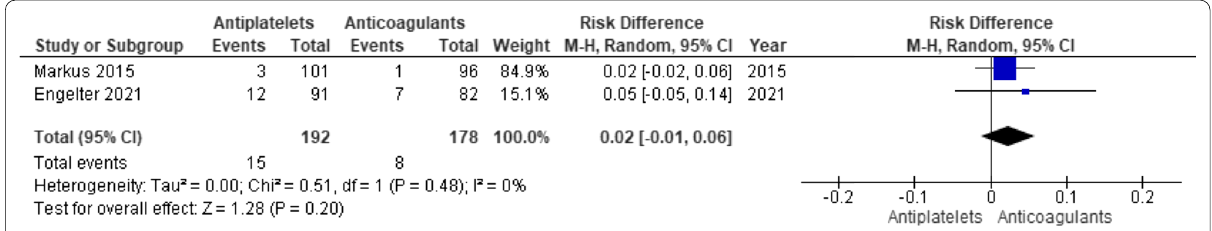
Fig. 5 Forest plot for ischaemic stroke outcome for RCTs